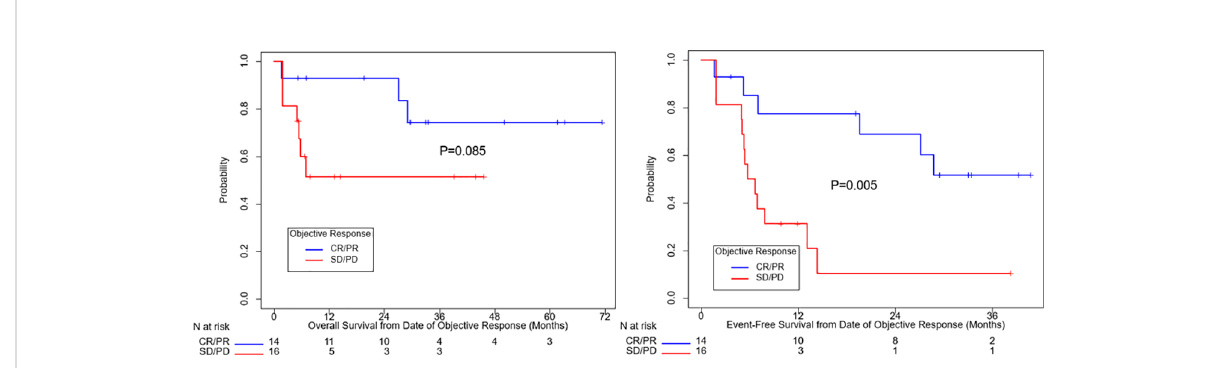
FIGURE 1 Overall survival and event free survival strati fi ed based on objective response per RECIST v1.1. CR, complete response, PR, partial response, SD, stable disease, PD, progressive